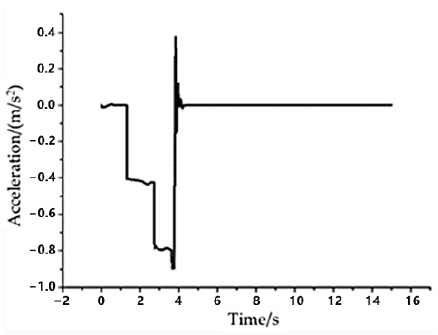
Figure 9. Acceleration change in the self-vehicle in CCRs test.